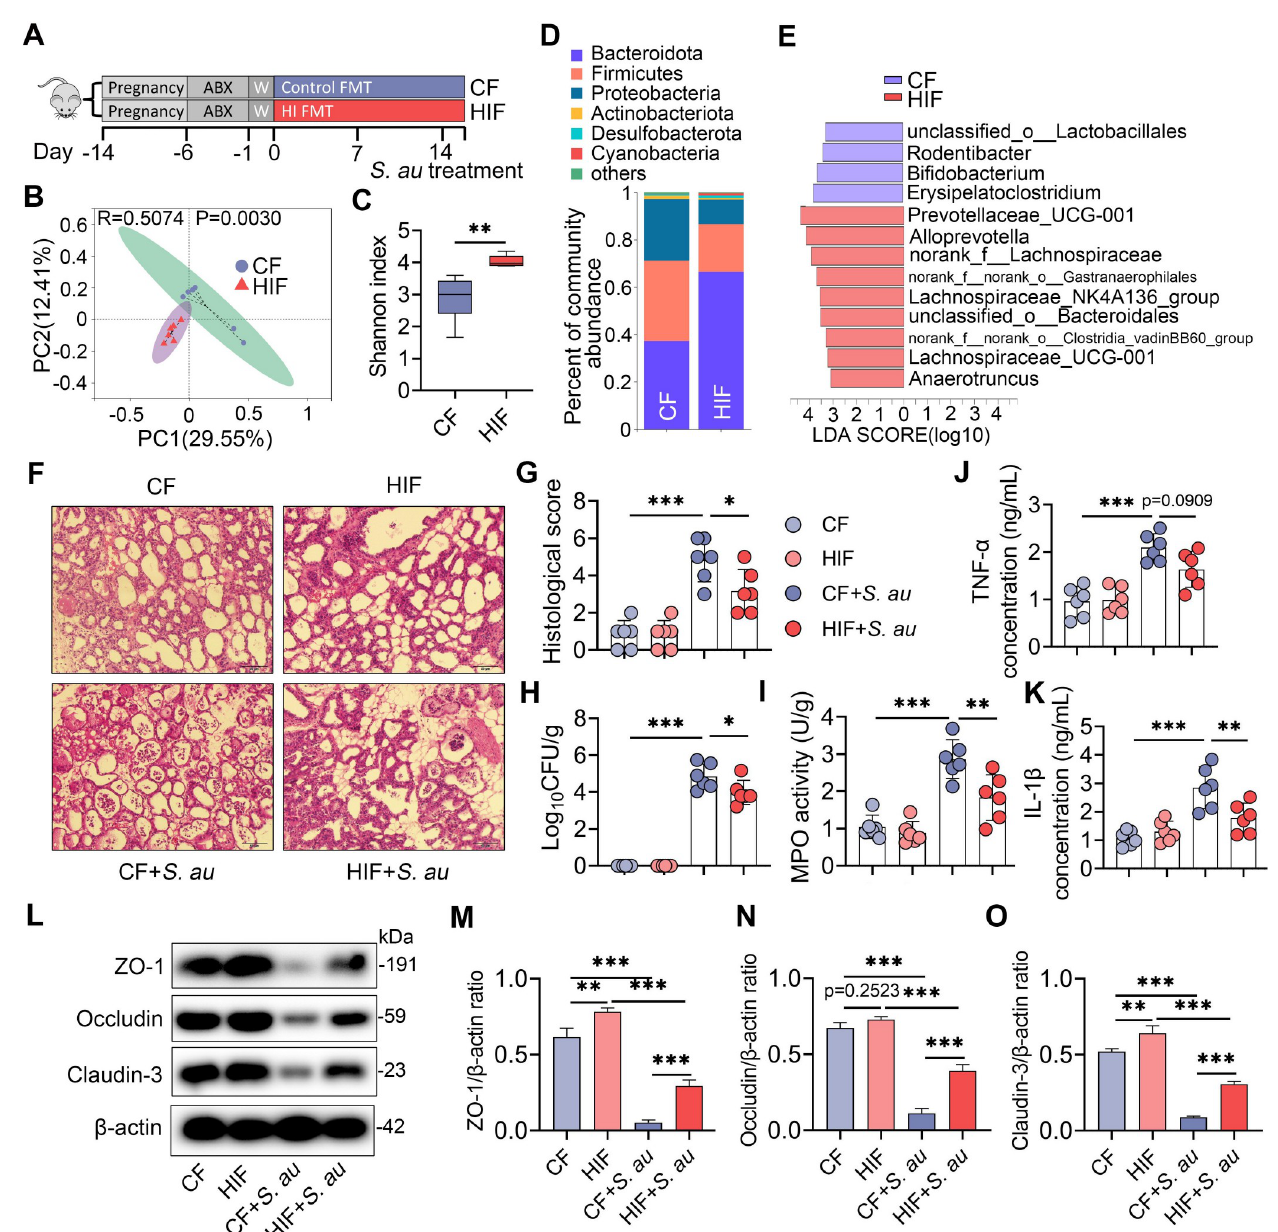
Fig 5. FMT from the HI diet treatment group improves S . au -induced mastitis in mice. A. Illustration of FMT. Pregnant mice were treated with ABX to deplete the commensal microbiota and then subjected to FMT from the control or HI treatment groups for two weeks (n = 6). B . PCoA showed different gut microbial structures between the CF and HIF groups based on unweighted UniFrac distance (R = 0.5074, P = 0.0030, n = 6). C . Shannon index from the indicated groups (n = 6). D . Gut microbial composition at the phylum level from different treatment groups (n = 6). E . LEfSe showed different bacterial taxa that were enriched in different groups (log10 LDA score > 3). F . Representative H&E-stained images of the mammary glands from different treatment groups (scale bar, 50 μ m). G . Histological score of the mammary gland based on H&E-stained sections (n = 6). H . Mammary bacterial burden from the indicated groups (n = 6). I-K . Inflammatory markers, including MPO activity ( I ), TNF- α ( J ) and IL- β ( K ), from the indicated groups (n = 6). L . Representative images of mammary TJ proteins, including ZO-1, Occludin and Claudin-3, by western blotting. M-O . Relative expressions of TJ proteins, including ZO-1 ( M ), Occludin ( N ) and Claudin-3 ( O ) were shown using β -actin as an endogenous control. Data are expressed as boxplots ( C ) or means ± SD ( G-K , M-O ), and the Mann-Whitney U test ( C ) and one-way ANOVA ( G-K , M-O ) were performed for statistical analysis. � p < 0.05, �� p < 0.01 and ��� p < 0.001 indicate significant differences.